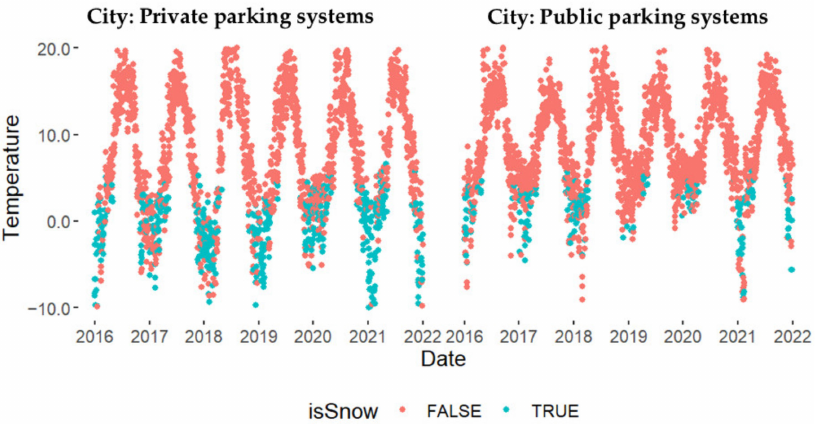
Figure 18. Weather data visualization (temperature and snow) for city private parking systems ( left ) and public parking systems ( right ).